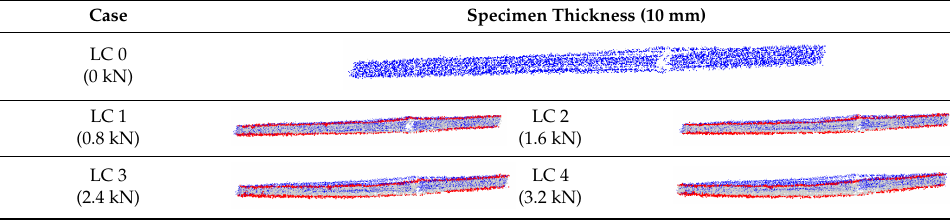
Table 7. Octree inner node visualization and node transformation area (10 mm